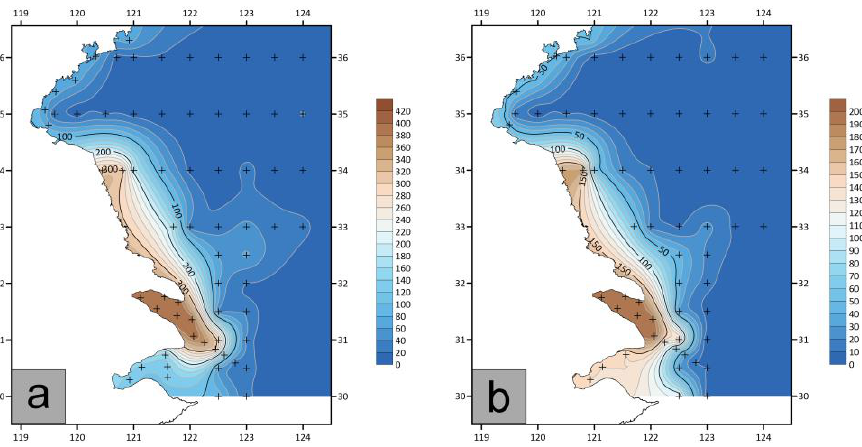
Figure 2. Concentration(mg/L) of suspended particulate matters in euphotic zone. ( a ) Bottom layer; ( b ) Surface layer.